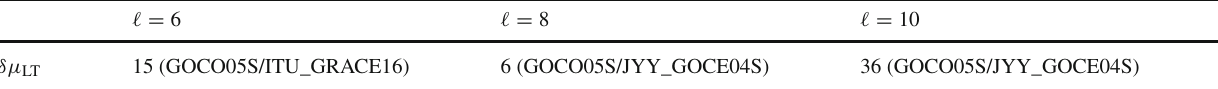
Table 9 Largest values of the percent uncertainties δμ LT ( % ) by degree (cid:3) according to Tables 4, 6, and